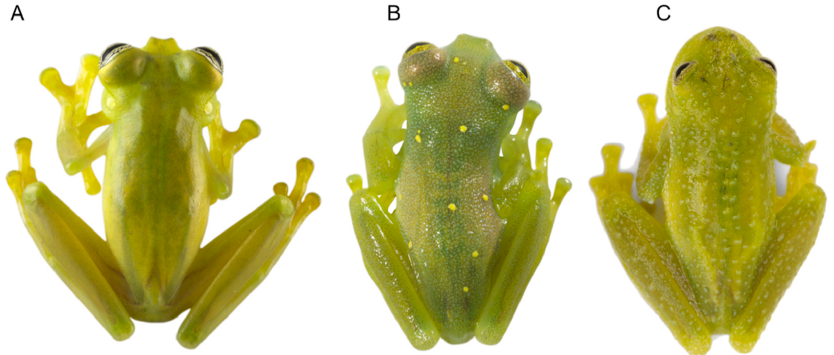
Figure 9. Skin texture in glassfrogs. ( A ) Smooth; Sachatamia ilex , QCAZ 47193. ( B ) Shagreen; Nymphargus humboldti sp. nov., ZSFQ 0833. ( C ) Pustular; Centrolene heloderma , QCAZ 40200.